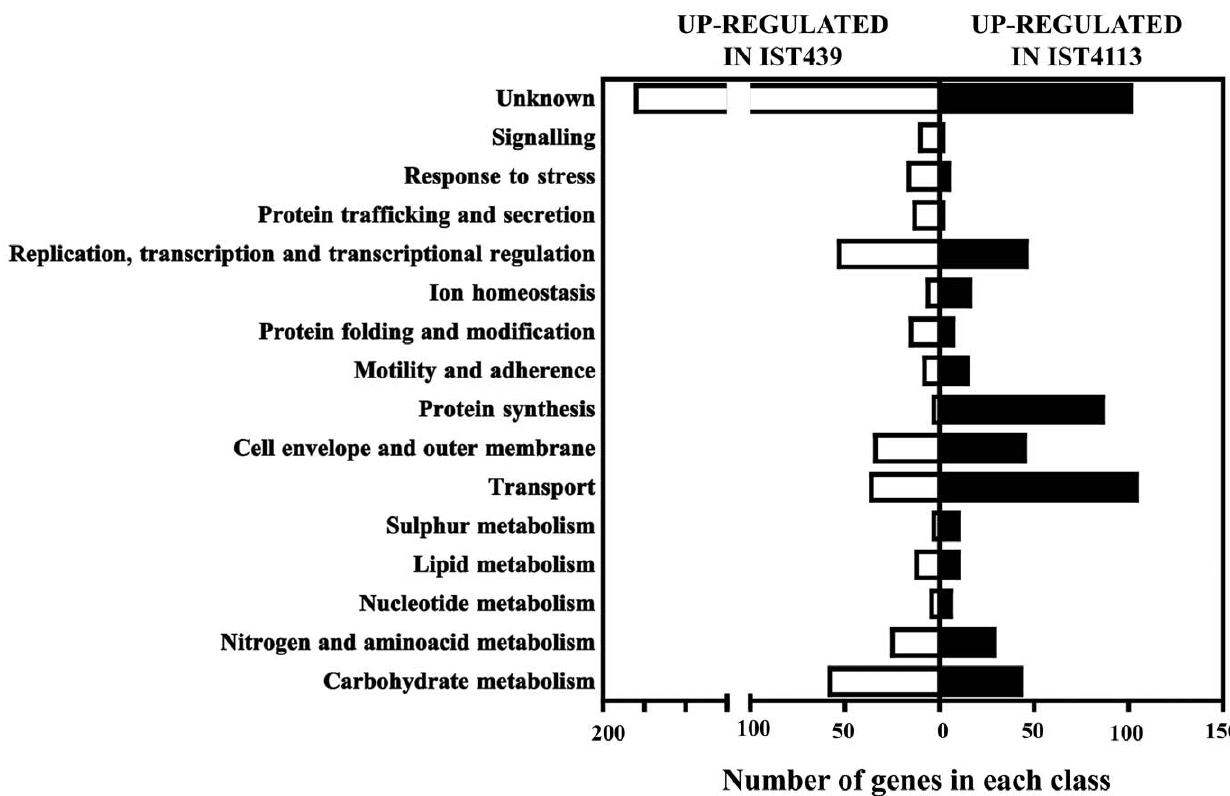
Figure 1. Clustering, based on biological function, of the genes found to be differently expressed in IST4113 (black bars) or in IST439 (white bars). The genes whose transcript level in the two variants varied above 1.5-fold were selected and grouped according to their biological function, based on the information available in the Burkholderia Genome database and in the KEGG Pathways Database.